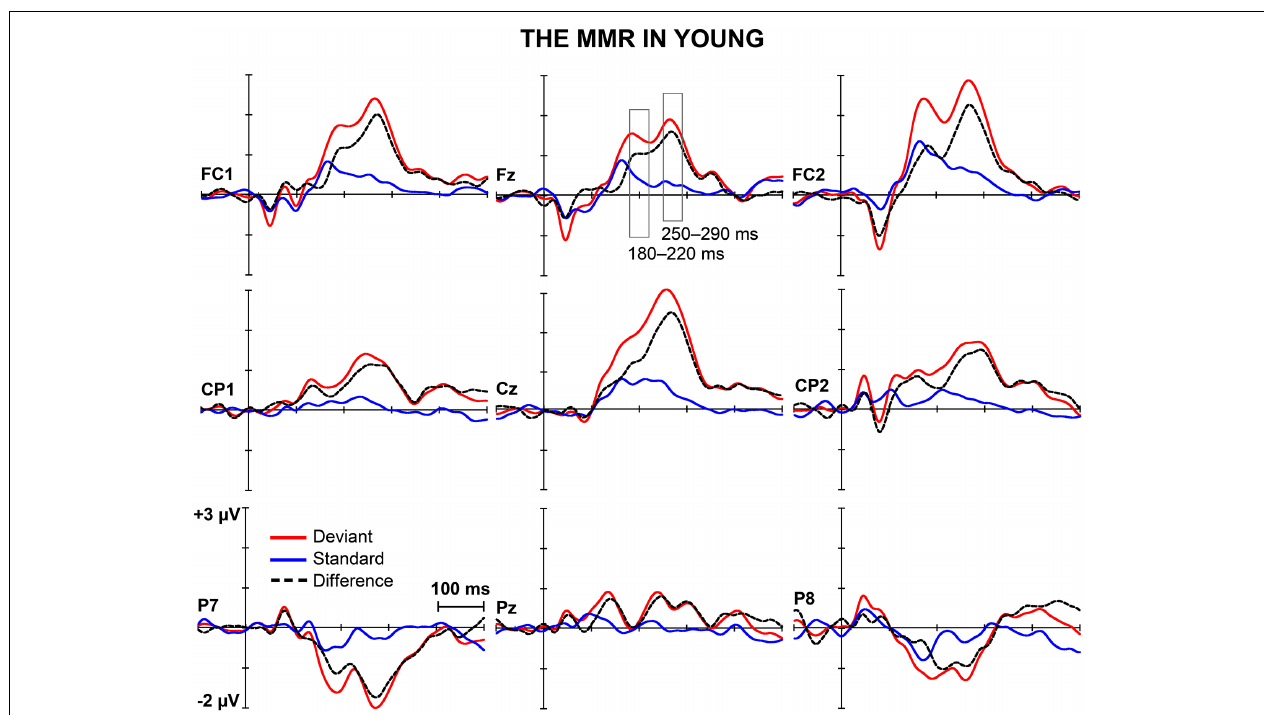
FIGURE 1 |The MMR in young. The grand-averaged waveforms to deviant and standard stimuli and a differential waveform (deviants minus standards) within young at electrode sites analyzed for the early and the late MMR.